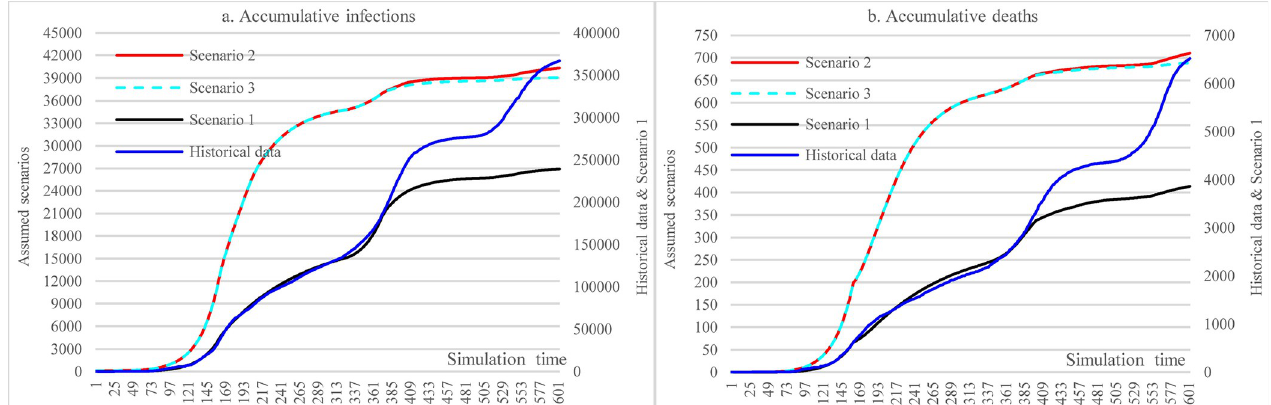
Fig 8. Impacts of imposing social distancing on major social events and routine life activities in counterfactual analysis.